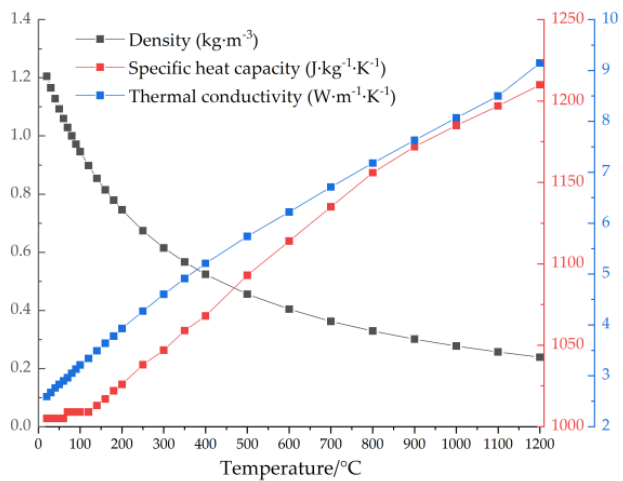
Figure 19. Curves of air density, specific heat capacity, and thermal conductivity.